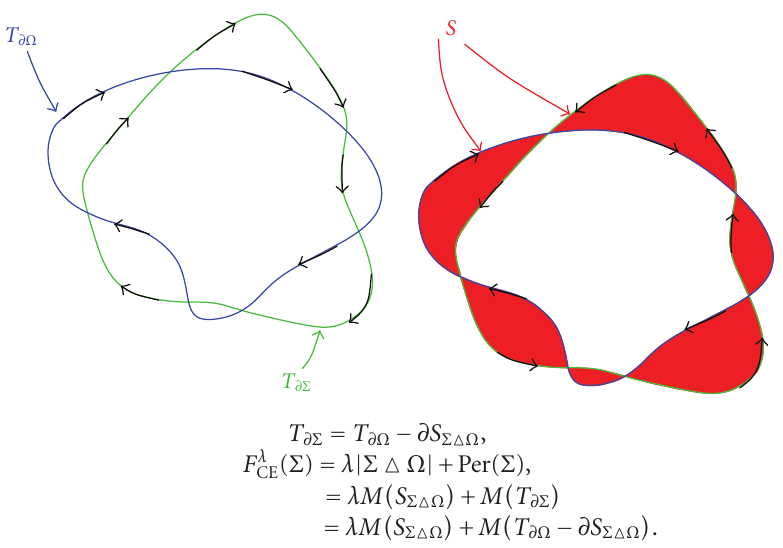
Figure 2.1. In this figure we illustrate the translation of the L 1 TV view to the flat norm view. The perimeter of Σ becomes the mass of T ∂ Ω − ∂S Σ (cid:2) Ω and the volume of Σ (cid:2) Ω becomes the mass of S Σ (cid:2) Ω . Note: this figure does not depict a minimizer. Rather, we depict Ω and any candidate Σ